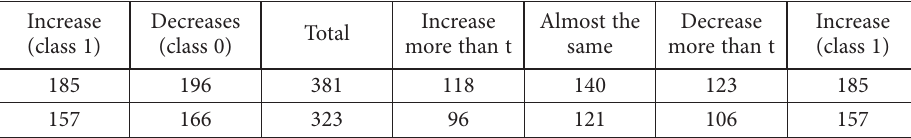
Table 5. Number of samples in E1 and E2 (source: authors’ calculation) Increase (class 1)